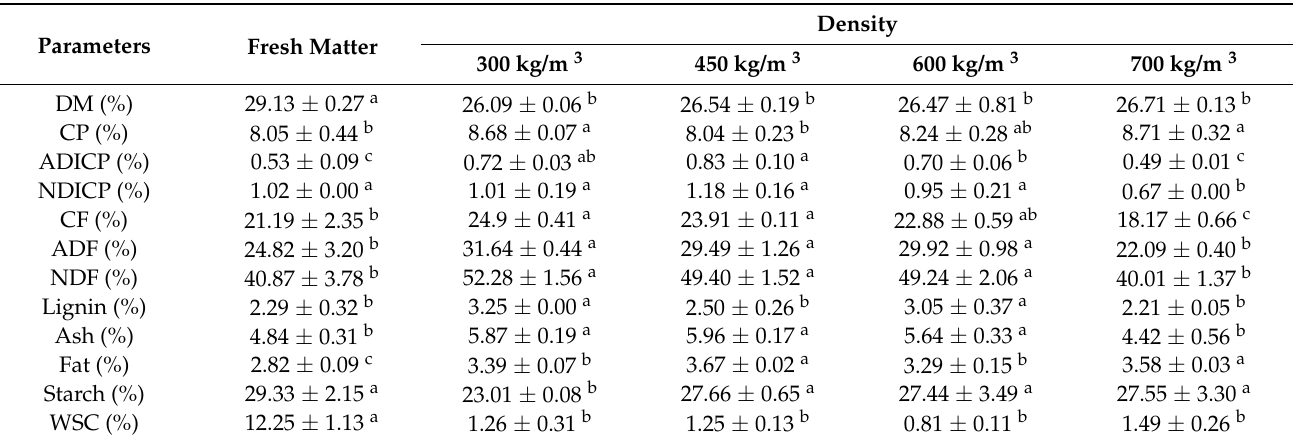
Table 3. Conventional nutrients of whole-plant corn silage with different compaction densities (dry matter basis).